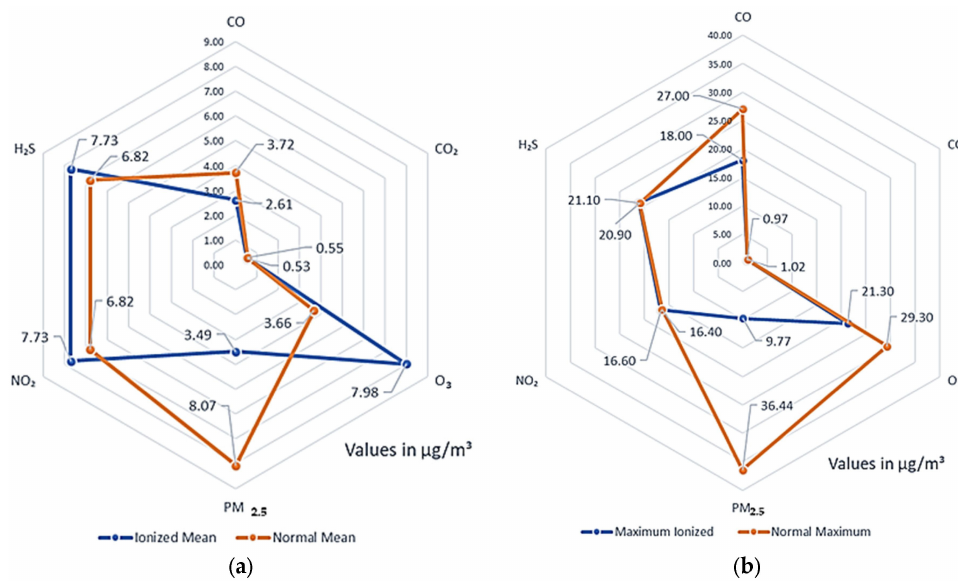
Figure 15. Radar plot analysis of ionized and normal gases: ( a ) mean, ( b )